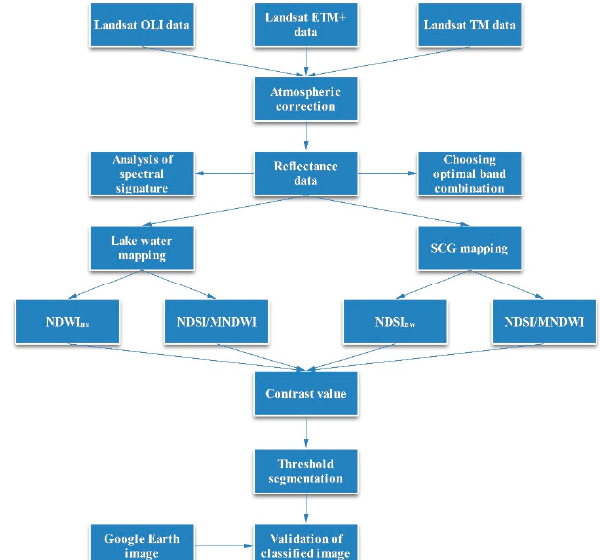
Figure 3. Flowchart of methodology. Water 2019 , 11 , x FOR PEER REVIEW